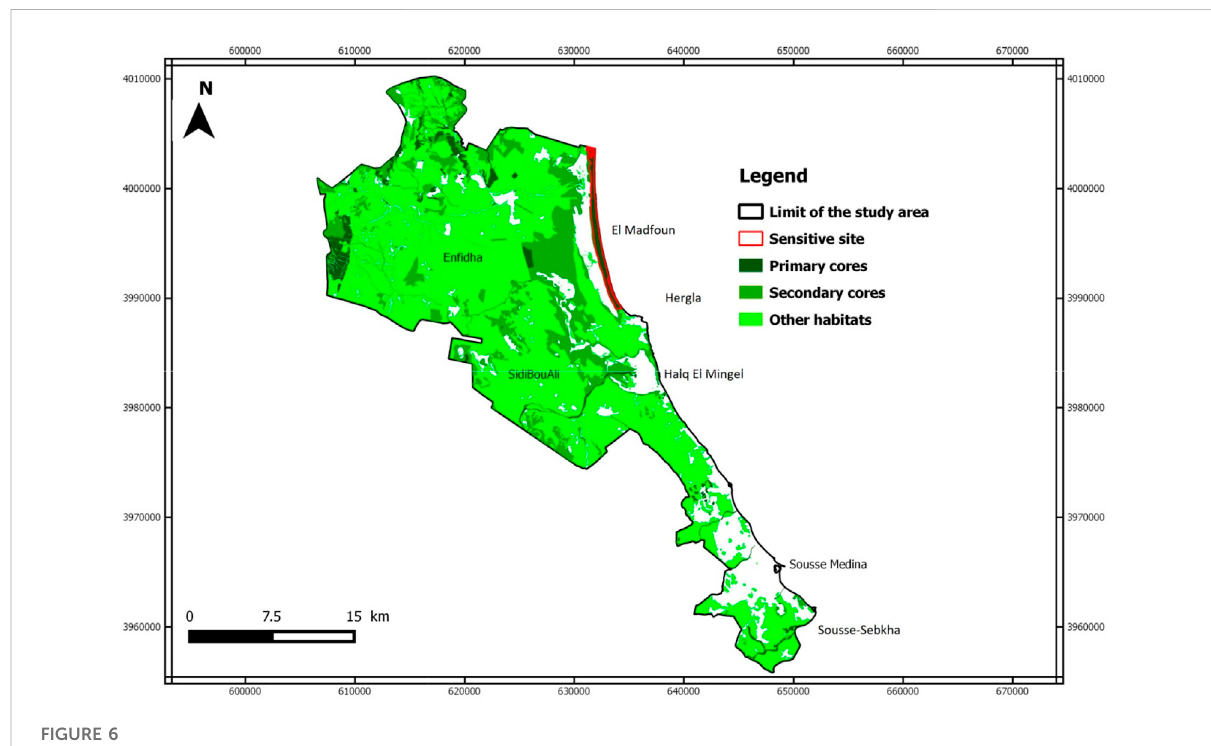
FIGURE 6 Reservoirs of the forest habitat